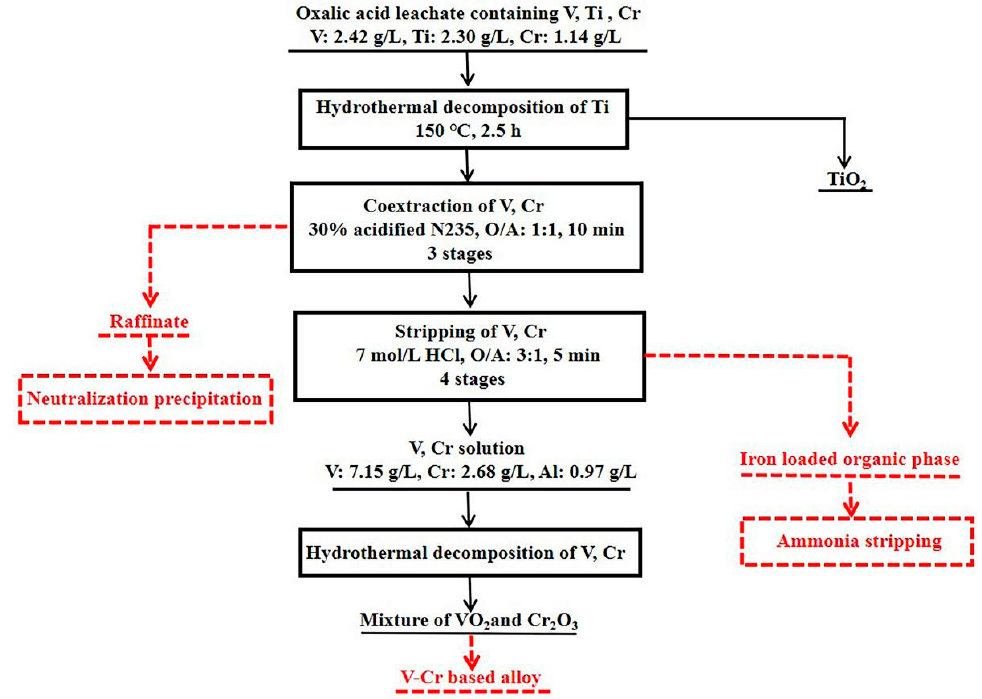
Figure 1. Flow diagram of separating titanium, vanadium and chromium from the oxalic acid leachate of vanadium slag.